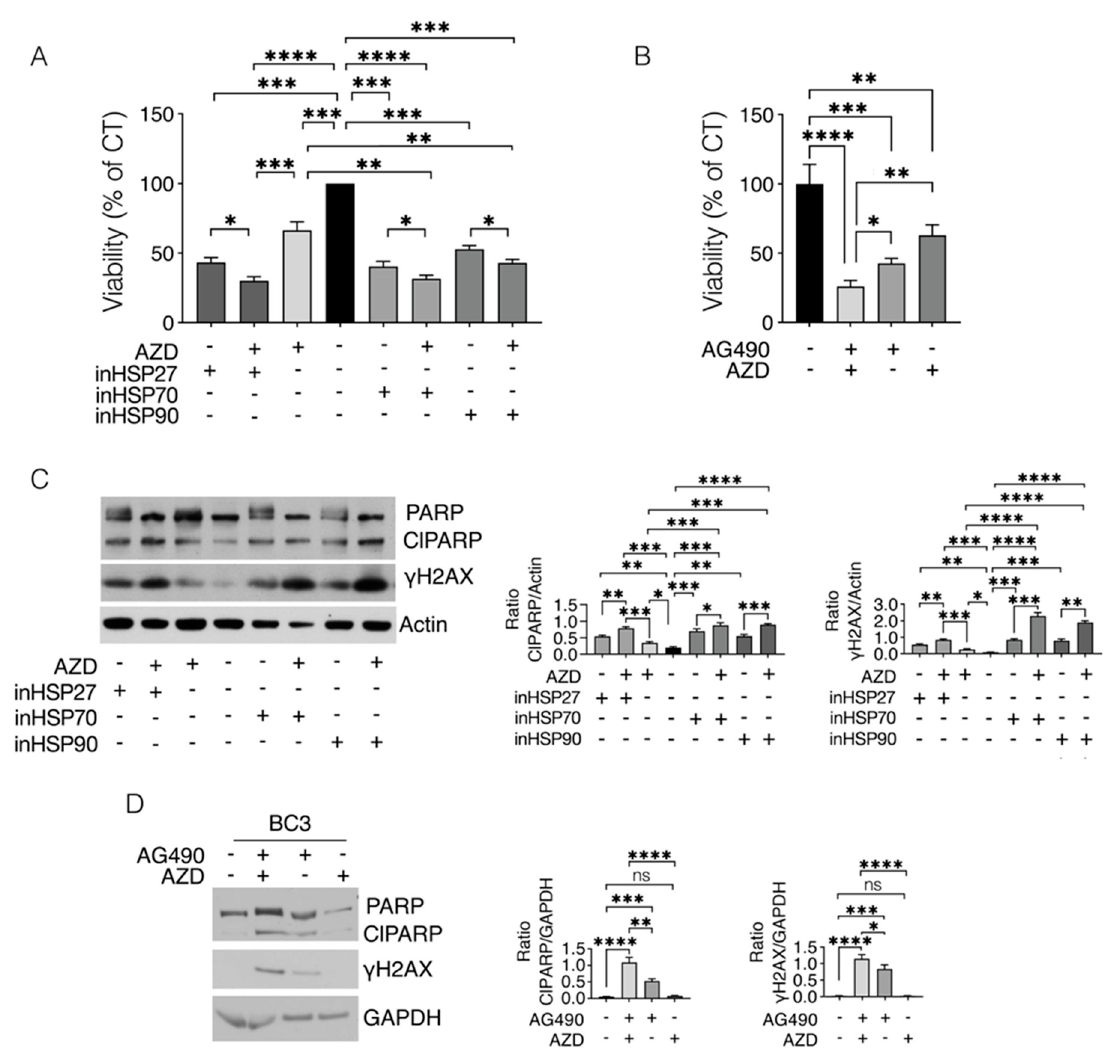
Figure 5. HSP or STAT3 inhibitors potentiate the cytotoxic effect of PARP inhibitor AZD2461 in PEL cells, by inducing stronger DNA damage. BC3 cell lines were treated with inHSP27 (J2) (10 µM), inHSP70 (PES) (10 µM), inHSP90 (17AAG) (0.1 µM) or AG490 (100 µM) singly or in combinations with AZD2461 (40 µM) for 24 h and ( A – B ) cell survival was evaluated by a trypan blue exclusion assay. The histograms represent the mean of the percentage of cell viability relative to the control plus S.D. p value: * <0.05; ** <0.01; *** <0.001; **** <0.0001. By calculating the KERN index, the cyto- toxic effect, induced by all combinations, was found to be additive (R = 1). ( C , D ) Protein expression levels of cleaved PARP (ClPARP) and γ H2AX were evaluated by Western blot analysis. Actin or GAPDH was used as a loading control and one representative experiment is shown. The histograms represent the densitometric analysis of the ratio of specific protein/actin or protein/GAPDH. Data are represented as the mean plus S.D. p value: * <0.05; ** <0.01; *** <0.001; **** <0.0001. ns = not significant 3. Discussion HSPs play a key role in the stabilization and function of proteins involved in im- portant biological processes, therefore targeting HSPs may have a strong impact on cell survival [14]. Their role is particularly important in cancer cells, as they express high levels of HSPs and strongly rely on them for protein-folding and for adapting to the stressful conditions that characterize their life [8]. This is also due to the fact that HSPs contribute to the stabilization of oncogenes, such as c-MYC [22] and mutant KRAS [23]. Previous studies from other laboratories, along with ours, have shown that targeting HSP70, as well